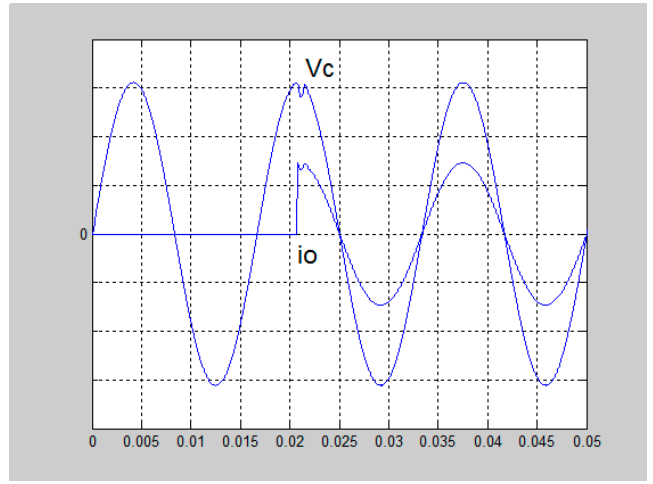
Figure 2. Simulated waveforms under step load change (load suddenly turn on) for the improved technique (50 V/div; 10 A/div).